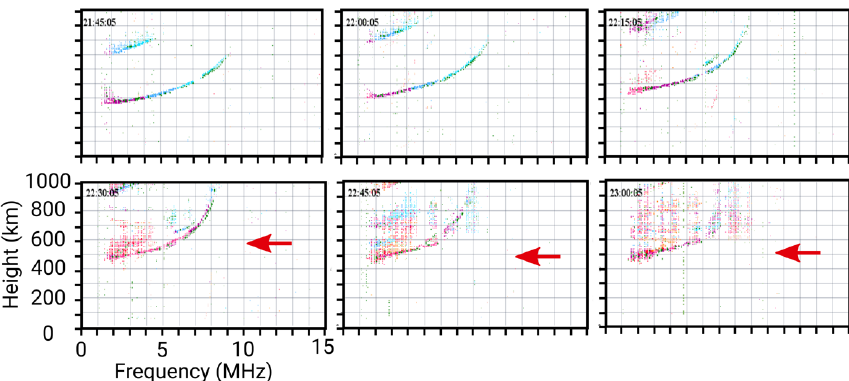
Figure 1. Sequences of ionograms showing the spread F over São Luís on 11 January 2001 (red arrows). Table 3. Statistics of the data used in this study for 2001 and